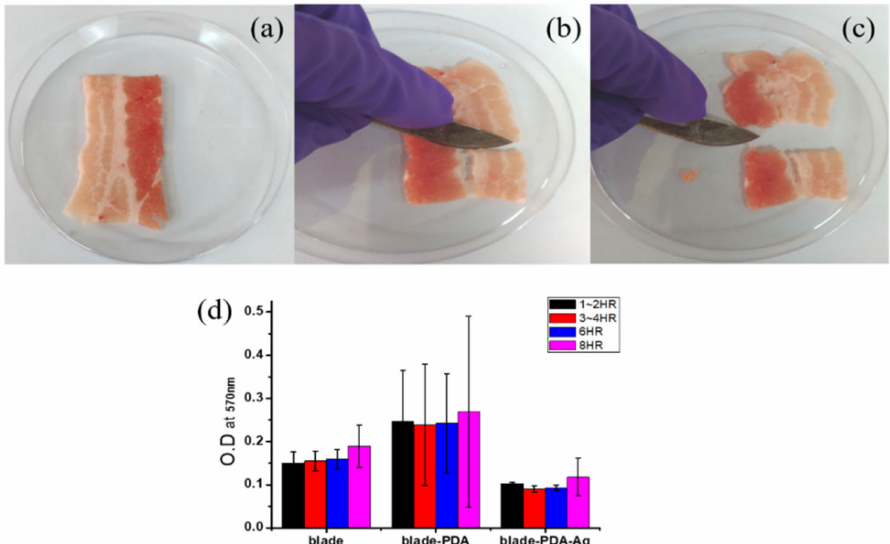
Figure A6. ( a – c ) photograph demonstrating the pork meat sample cut using Ag/PDA modified surgical blade; ( d ) Nor- malized optical density bacterial growth ( E. coli ) peak with respect to time. The experiments were performed in triplicate, and the error bars indicate the standard deviations from the mean